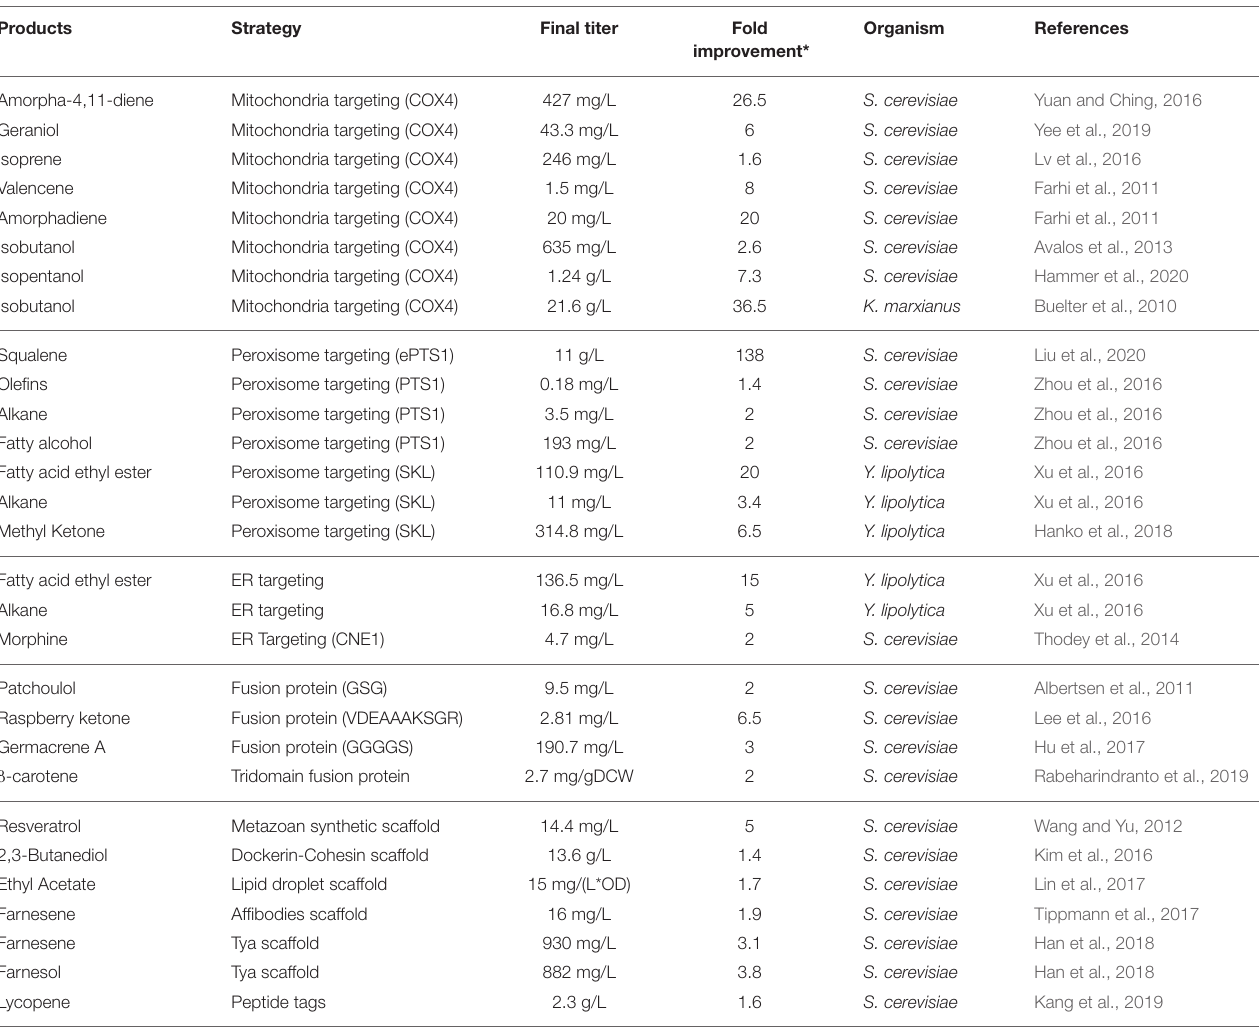
TABLE 1 | Enzyme colocalizations studies in yeast and the resulting improvements in product titer.